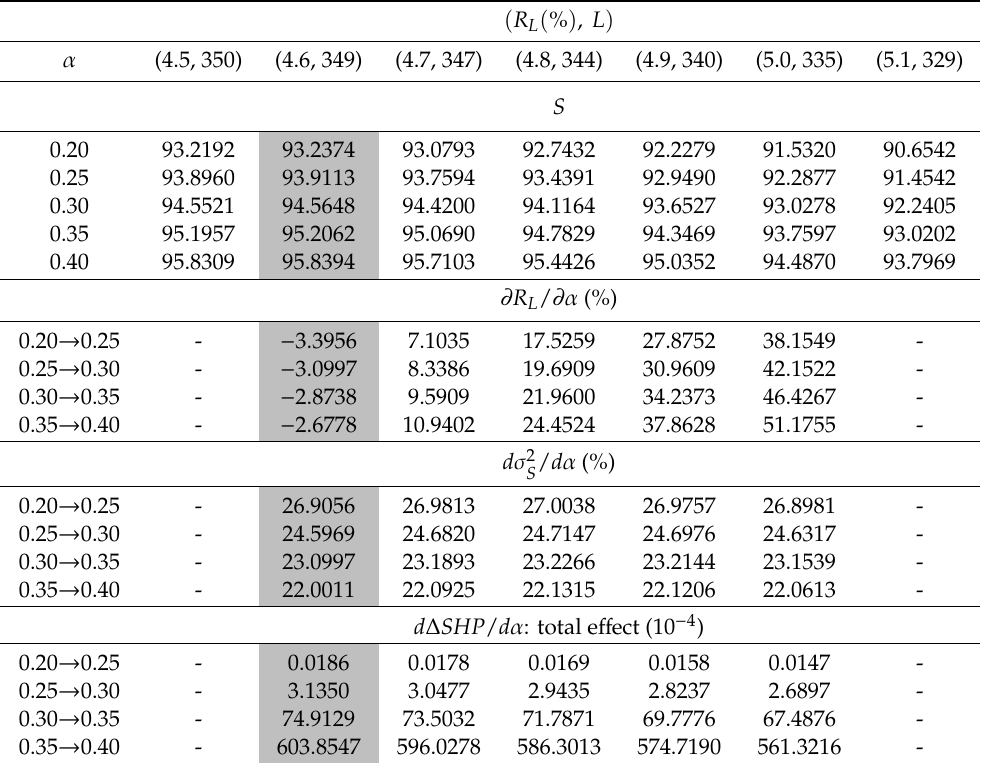
Table 2. E ff ects of international loan portfolio diversification degree on domestic loan rate, equity risk, and diversification e ffi ciency.